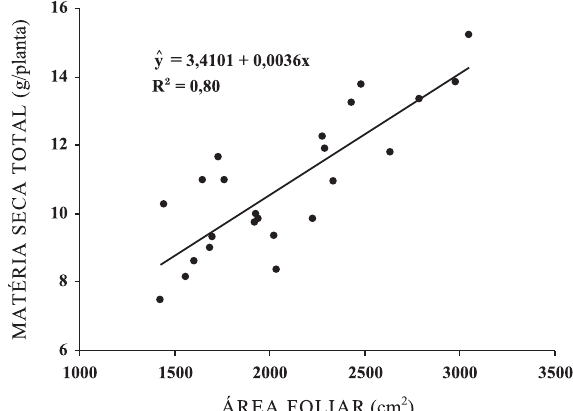
Figura 1. Matéria seca total das mudas de eucalipto em função da área foliar, para os seis clones de